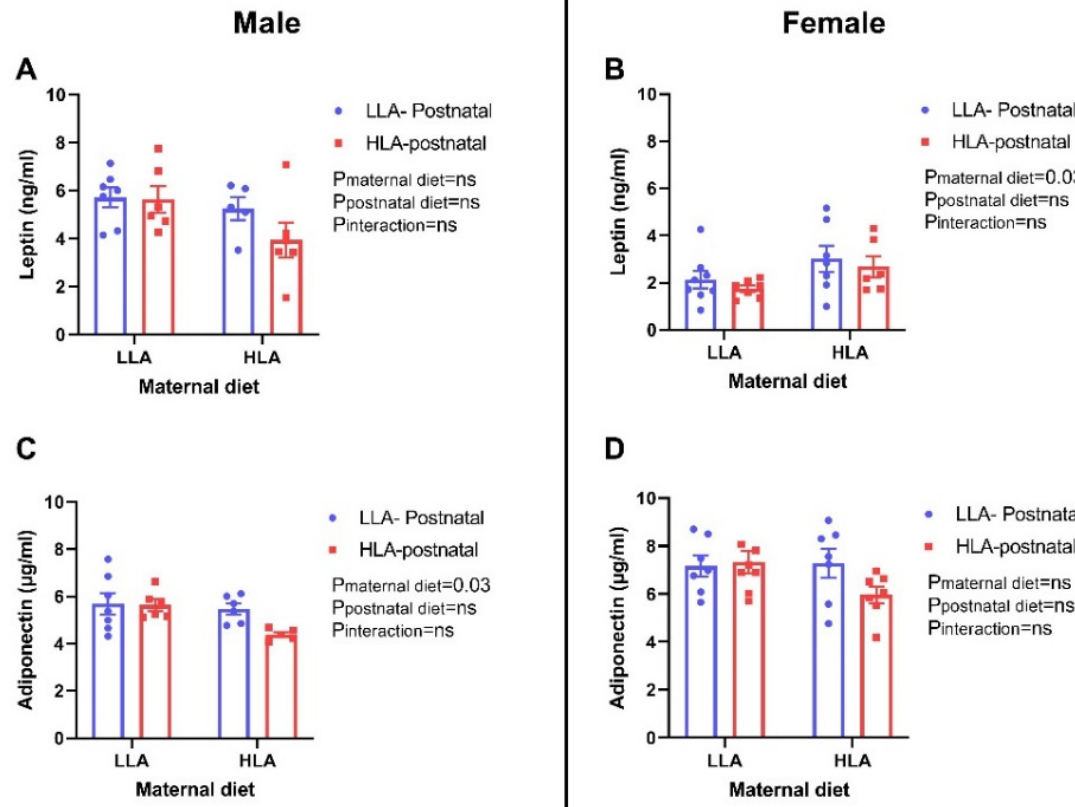
Figure 5. Effect of a maternal and postnatal diet high in linoleic acid on circulating leptin and adiponectin in adult offspring. Data are presented as mean ± standard error of the mean (SEM). Two-way ANOVA was performed for statistical analysis with maternal diet and postnatal diet as two factors. n = 5–8. LLA: low linoleic acid; HLA: high linoleic acid; PN: postnatal. A : Leptin concentration male; B : Leptin concentration female; C : Adiponectin concentration male; D : Adiponectin concentration female.